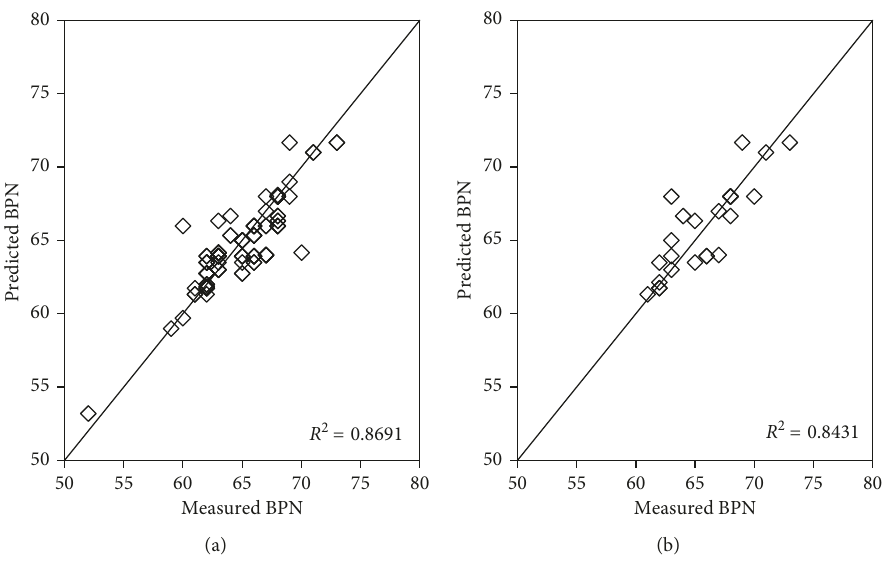
Figure 4: Comparison of the measured BPN values with the predicted BPN values from the ANN-1 model for (a) training and (b) testing samples under sand blasting condition.